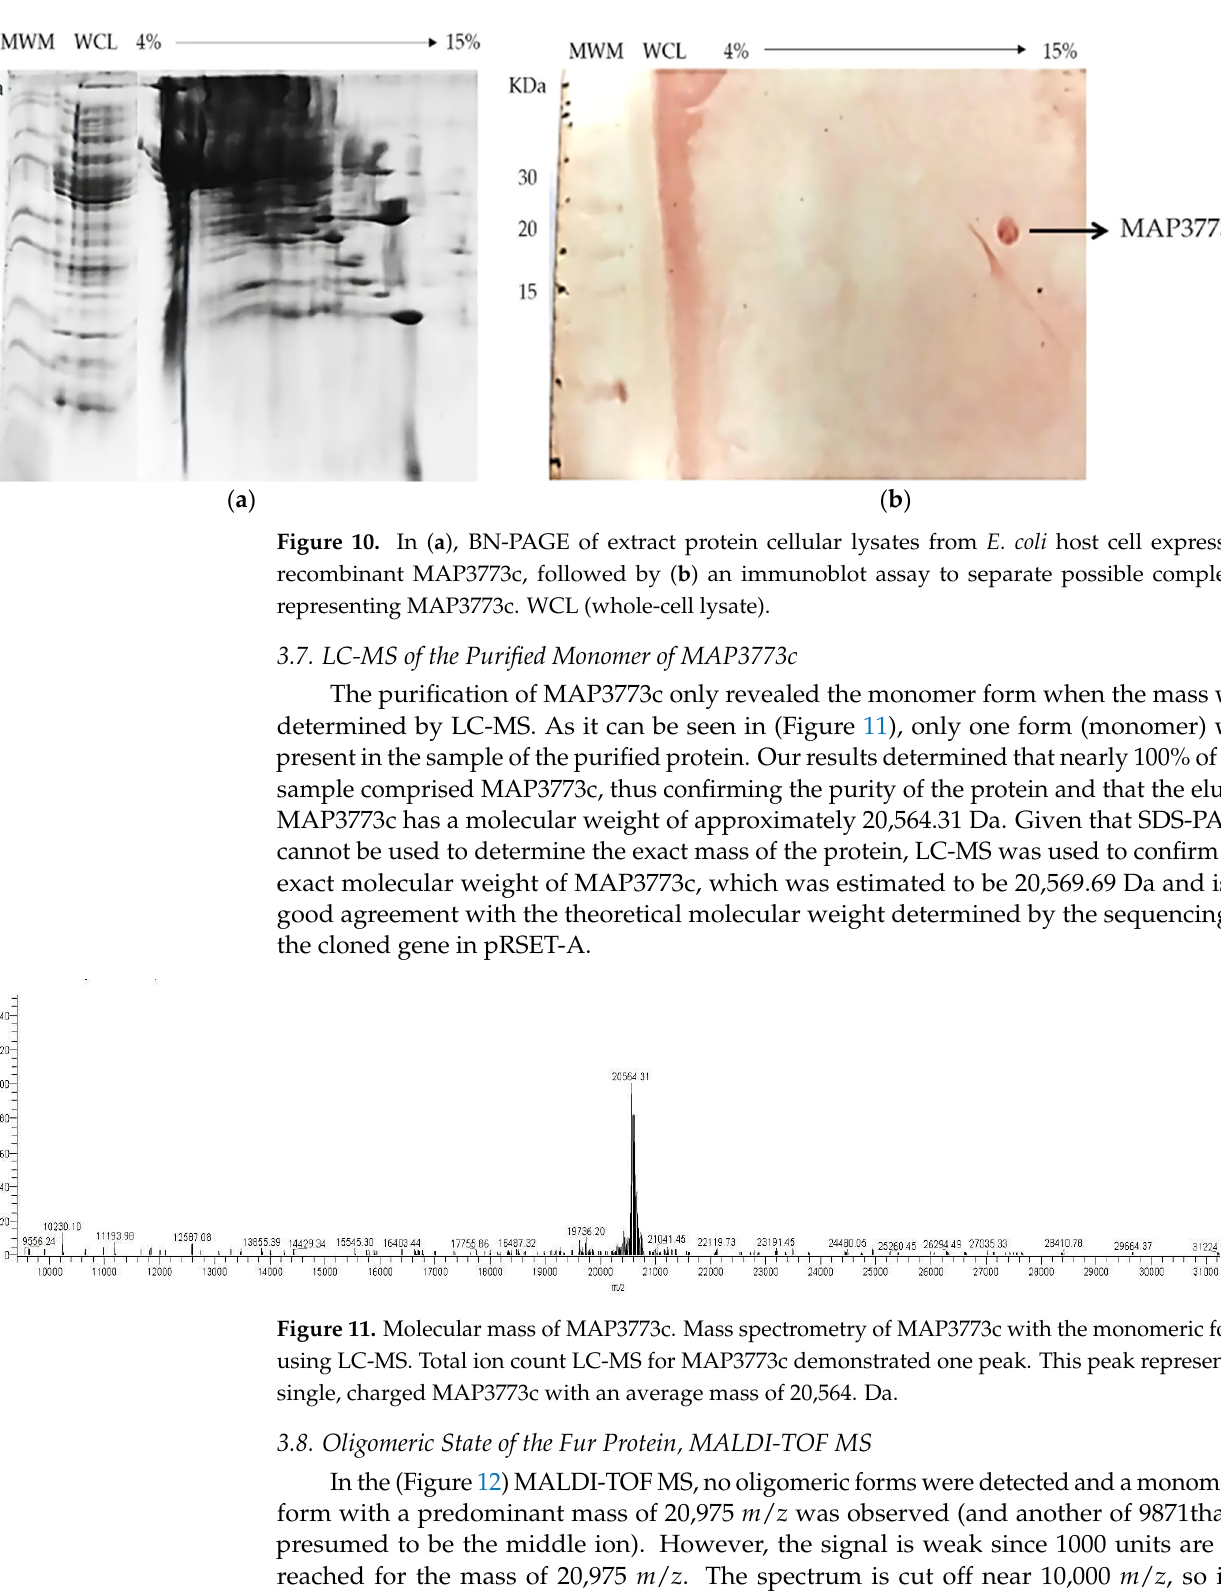
16 of 20 Figure 8. Western blot analysis of MAP3773c tested with antibodies raised against recombinant FurA and FurB from Anabaena sp. PCC7120. Line 1, MWM; Line 2, Western blot of FurA from Ana- baena sp. PCC7120 protein tested with antibodies raised against FurA; Line 3, MAP3773c tested with antibodies anti-FurA from Anabaena sp. PCC7120; Line 4, FurB from Anabaena sp. PCC7120 tested with anti-FurB antibodies; Line 5, MAP3773c tested with Anabaena sp. PCC7120 anti FurB antibod- ies. Figure 9. Bioinformatic alignment of the amino acid sequences of the MAP3773c protein of MAP and FurB of Anabaena sp. PCC7120. WP_010996629. 3.6. BN-SDS PAGE and BN PAGE Immunoblotting BN-PAGE (Figure 10) allows the analysis of the aggregation or oligomeric states of proteins in cell extracts. To analyze whether the MAP3773c protein formed multiprotein complexes, i.e., dimers, trimers, etc., we first separated the protein in 2D under native